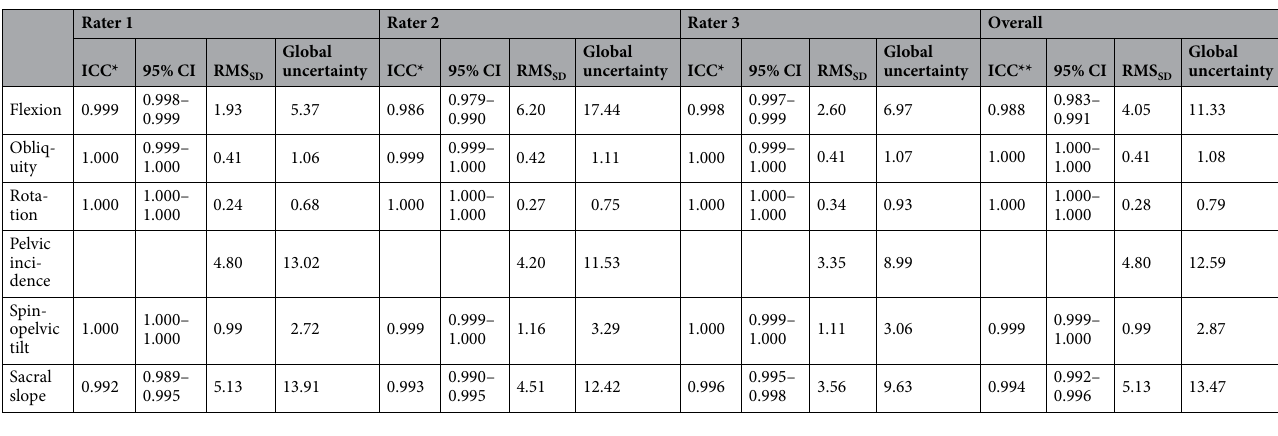
Table 2. Precision of EOS measurements in terms of pelvic parameters and orientation.